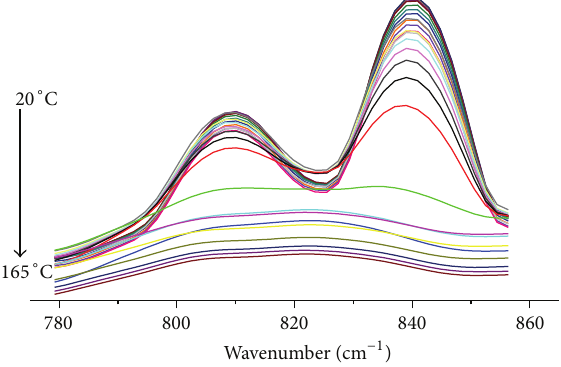
Figure 9: FTIR spectra of PP/PANI 4 at different temperatures (780–856 cm −1